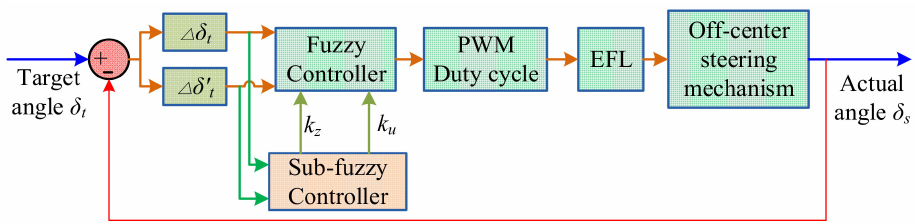
Figure 8. Schematic diagram of the fuzzy control method.